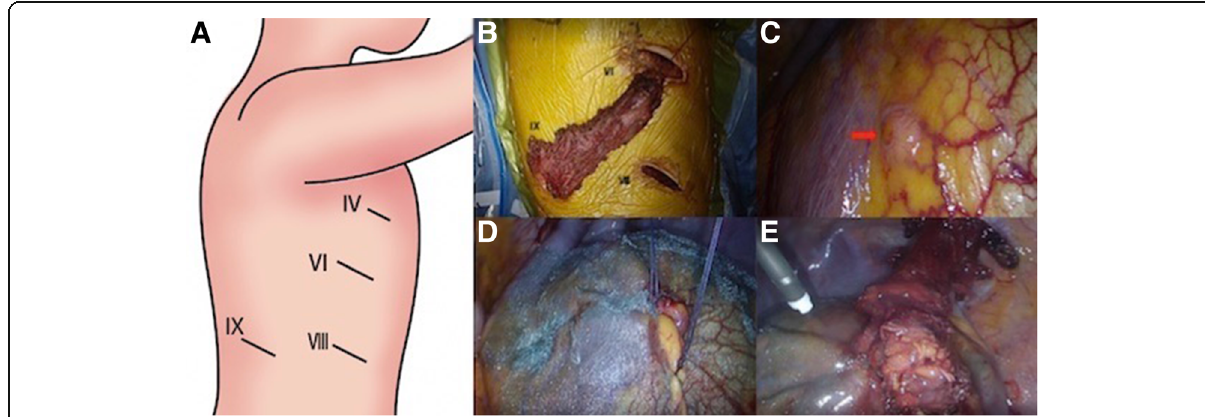
Fig. 2 Intraoperative findings. a One 2-cm and three 3-cm skin incisions were made at the fourth, sixth, eighth, and ninth intercostal spaces on the posterior axillary lines, respectively. The line marked with “ IV ” indicates the fourth intercostal space; “ VI, ” the sixth intercostal space; “ VII, ” the eighth intercostal space; and “ IX, ” the ninth intercostal space. b The latissimus dorsi muscle (LDM) was accessed and separated from the lower part to the upper along the muscle fiber, and the half of the muscle was eventually harvested as a pedicled LDM flap. c A small hole was observed at the right central tendon of the diaphragm (red arrow). d The small hole was closed with two 2-0 absorbable multifilament sutures. The central tendon around the reinforcement was covered with a sheet of absorbable polyglycolic-acid felt. e The harvested pedicled LDM flap was inserted from the ninth intercostal space of the posterior axillary line. The small hole was reinforced by the harvested pedicled LDM flap. The central tendon around the reinforcement was sprayed with fibrin